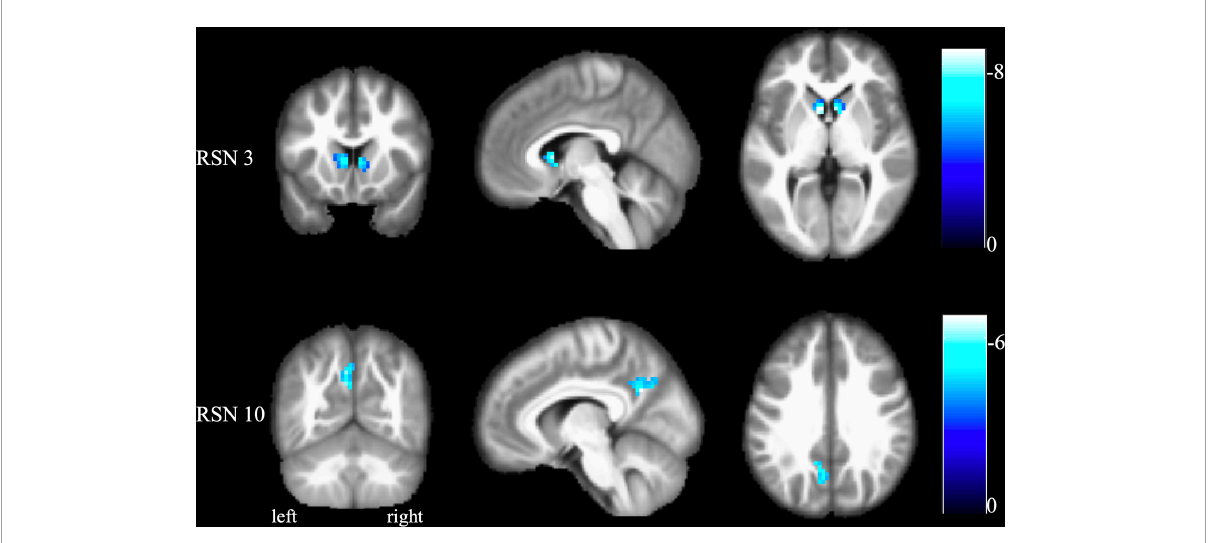
FIGURE2 The results of the intranetwork difference between FCon patients and healthy controls. Altered functional activities were found in RSN 3 (bilateral basal ganglia and thalamus) and RSN 10 (default mode network). No difference was found in other RSNs. The color bar indicates the t -value of the two-sample t -test between FCon patients and healthy controls. A negative t -value means significantly lower functional activity in the FCon patients. FCon, functional constipation; RSN, resting-state networks.